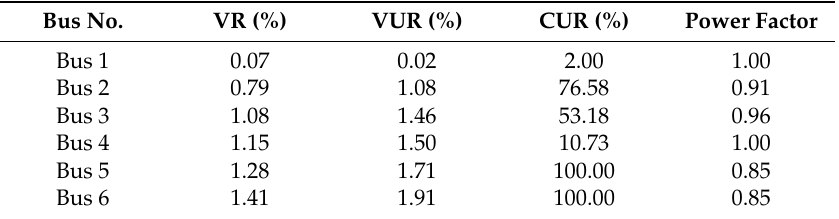
Figure 10. Power flow of Case 3. Table 4. Test result of Case 3. Table 4. Test result of Case 3.